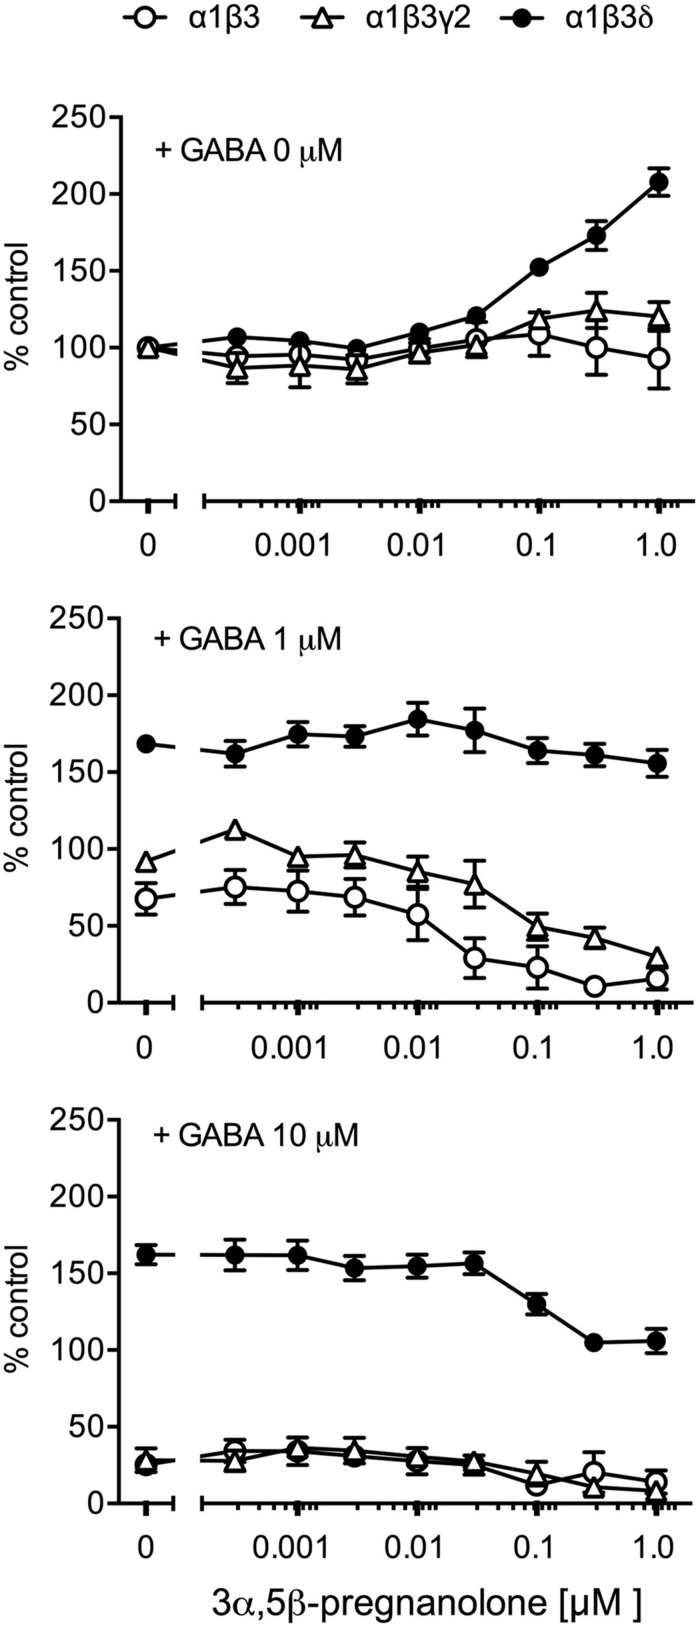
Effects of pregnanolone on GABAA receptor subtypes in the presence and absence of GABA. GABAA receptors of the given subunit combinations were transiently expressed in HEK 293 cells and incubated with 3 nM [3H]EBOB in the presence and absence of GABA and increasing concentrations of pregnanolone, as indicated. Data are presented as the means ± SEM, n = 3–5. All data were normalized to the [3H]EBOB binding with setting 0-μM GABA + 0-μM pregnanolone to 100%.